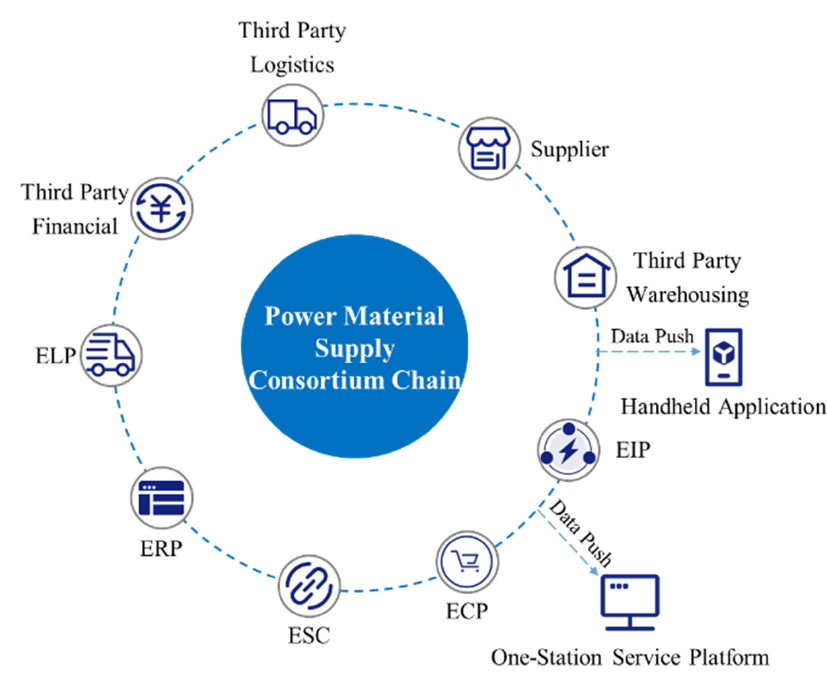
Figure 2. Power material supply deployment structure based on blockchain.